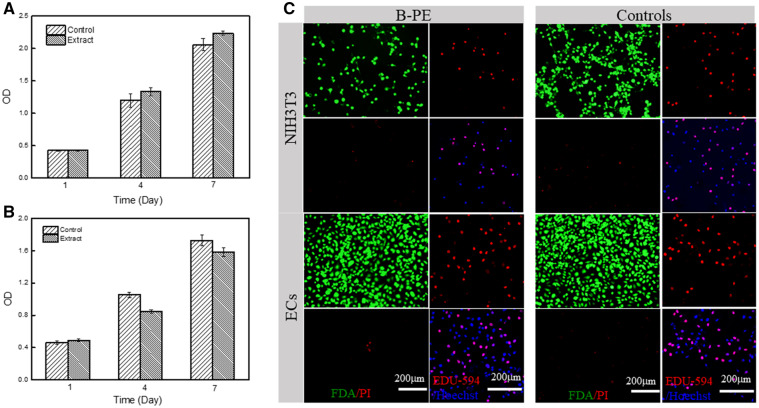
Cytotoxicity of B-PE material. The viability of (A) NIH3T3 fibroblasts and (B) human vascular ECs as a function of culture time. Cells were cultured in DMEM extract from B-PE material and the normal DMEM medium, respectively. Error bars represent means ± SD (n = 5). (C) Viability and proliferation of NIH3T3 fibroblasts and human vascular ECs on B-PE films. Living cells were stained by FDA, and dead cells were stained by propidium iodide. EdU uptake was stained by Alexa Fluor 594, and nucleus was stained by Hoechst 33342. Cells were cultured on B-PE films and TCPS control, respectively